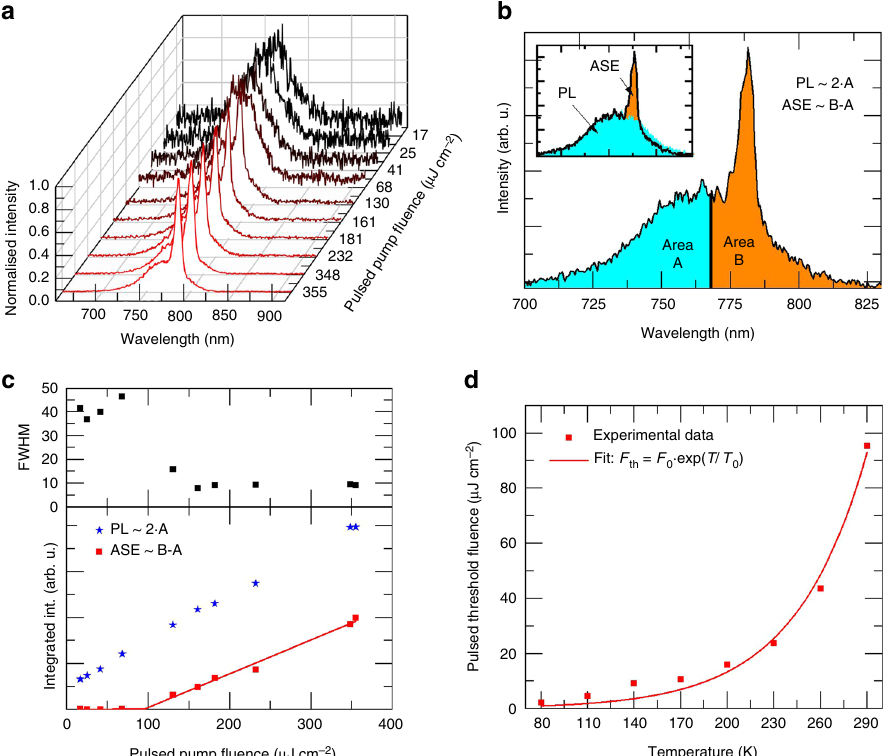
Fig. 1 Ampli fi ed spontaneous emission properties under pulsed excitation (~0.8 ns). a Example of data for room temperature showing the evolution of the emission spectra from which the ampli fi ed spontaneous emission (ASE) threshold is established. Different colors for the spectra are chosen for better distinguishability. b Regions of the spectrum used to determine spontaneous emission (PL) and ASE contributions. The inset graphically shows the assigned PL contribution (blue, area A and area A mirrored at the center wavelength) and ASE contribution (orange, area B – area A) and the real spectrum (black line). c PL, ASE, and full width at half maximum (FWHM) as a function of the pulse fl uence. d ASE threshold as a function of temperature. The threshold decreases by more than an order of magnitude from room temperature to 80 K. The red line is a fi t to the empirical exponential threshold law typically observed in inorganic semiconductors. The characteristic temperature T 0 is found to be 46